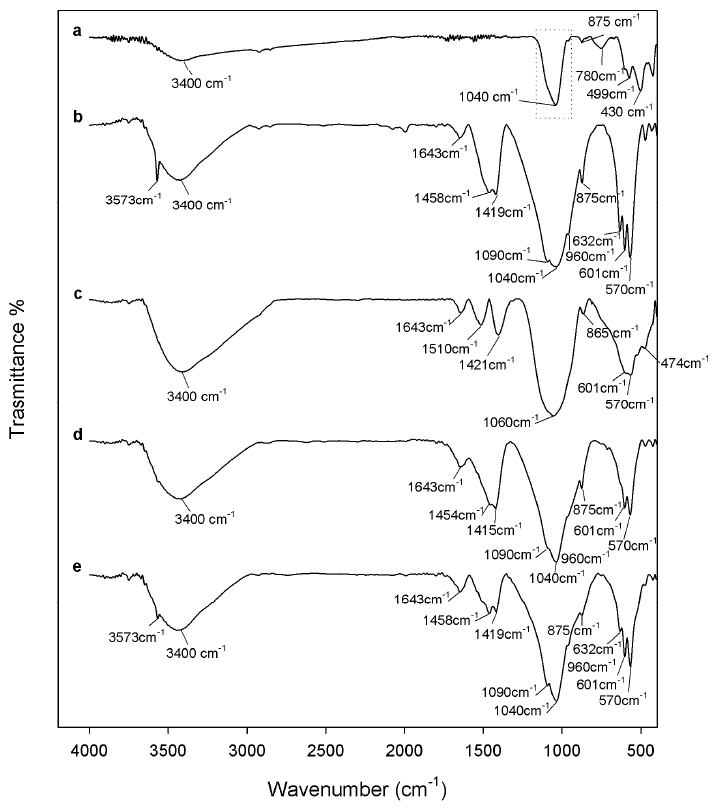
Figure 7. FTIR of ( a ) ZrO 2 ; ( b ) Hap; ( c ) 9ZrO 2 ·1Hap; ( d ) 7ZrO 2 ·3Hap; and ( e ) 5ZrO 2 ·5HAp gels, heated to 600 °C, after 21 days of exposure to Simulated Body Fluid (SBF).